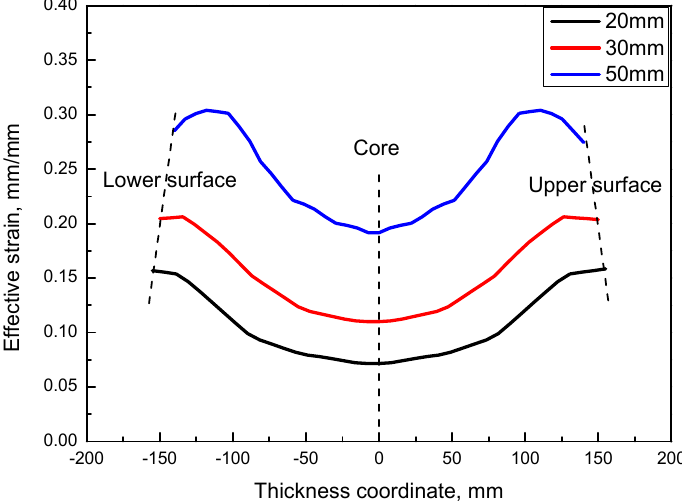
Figure 8. Values of e ff ective strain after the HHR 2 process at the thickness direction along z = 0. Di ff erent from the e ff ective strain, the strain rate is not cumulative value, but instantaneous value during the HHR 2 process. Three characteristic locations are selected to describe the evolution of strain rate in deformation, which are upper surface, 1 / 4 the thickness of the slab, and core of the slab, along the direction of z = 0, as shown in Figure 9. Generally, the strain rate increases first and then decreases in the hot rolling zone. Higher strain rates are obtained for higher reduction ratio of the slab. Meanwhile, greater values are observed at the upper and lower surfaces of the slab compared with the other characteristic locations.